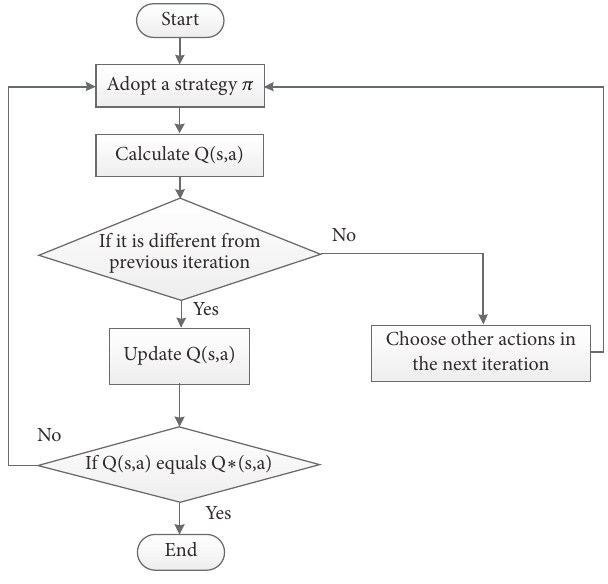
Figure 4: Training flowchart of